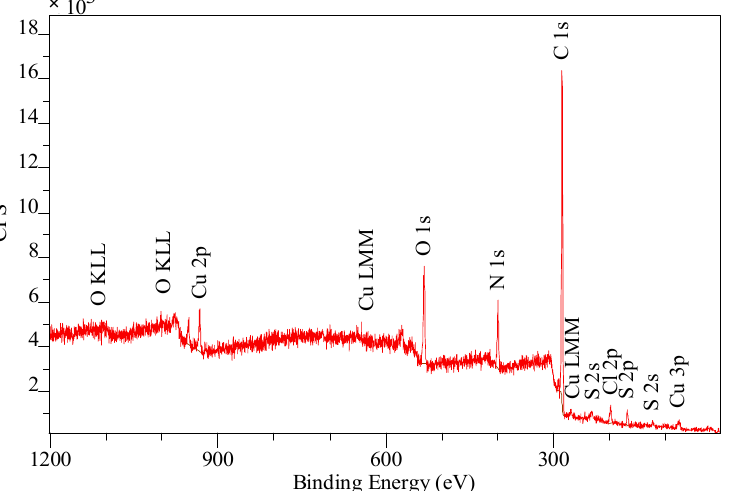
Figure 8. XPS spectrum obtained in a wide range of binding energy made for the Dowex M 4195 after the Cu(II) sorption. Table 9. The results of XPS analysis obtained in a narrow range of binding energy for Dowex M 4195 after Cu (II) sorption.